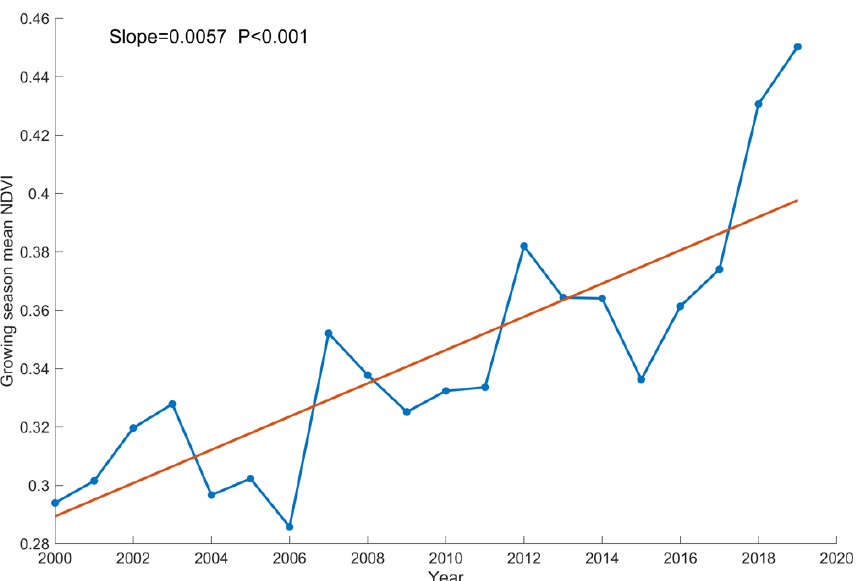
Figure 6. Time series and trend of the growing season mean NDVI for the study area from 2000 to 2019. The growing season is defined as May to September.